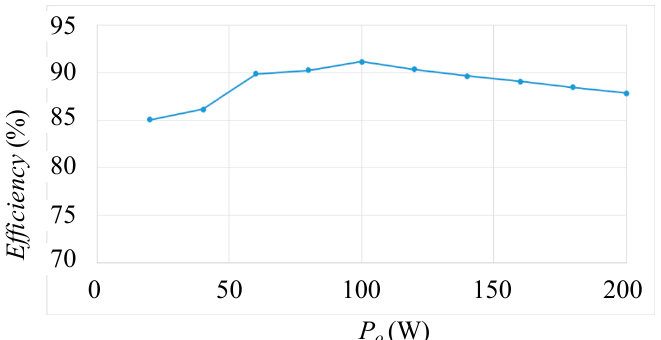
Figure 19. The conversion efficiency of the proposed converter.